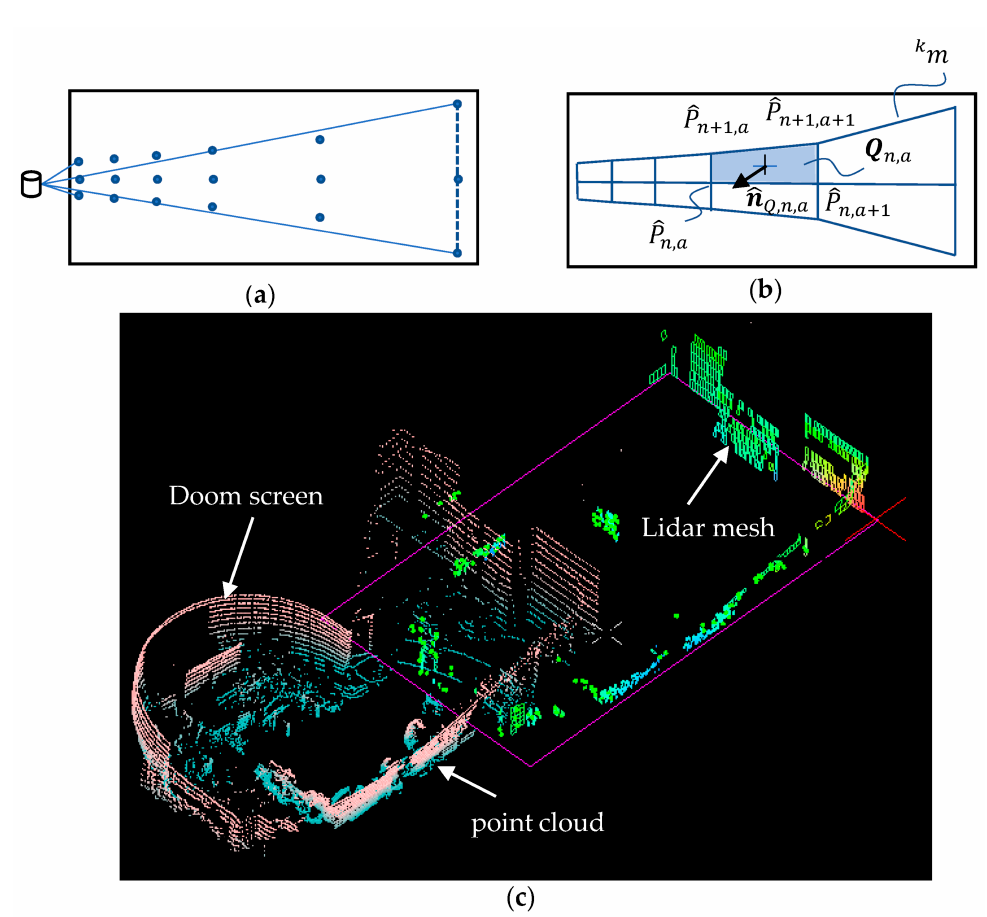
Figure 3. LiDAR mesh formation: ( a ) point cloud, ( b ) polygonal quads, and ( c )